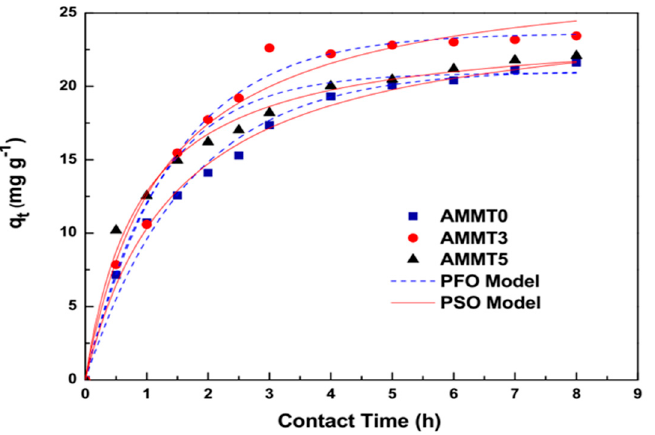
Figure 9. Non-linear regression of kinetic models on the MB retention by AMMT0, AMMT3, and AMMT5 samples (initial dye amount: 25 mg L − 1 , adsorbent dosage: 0.01 g, temperature: 25 °C, volume: 10 mL).